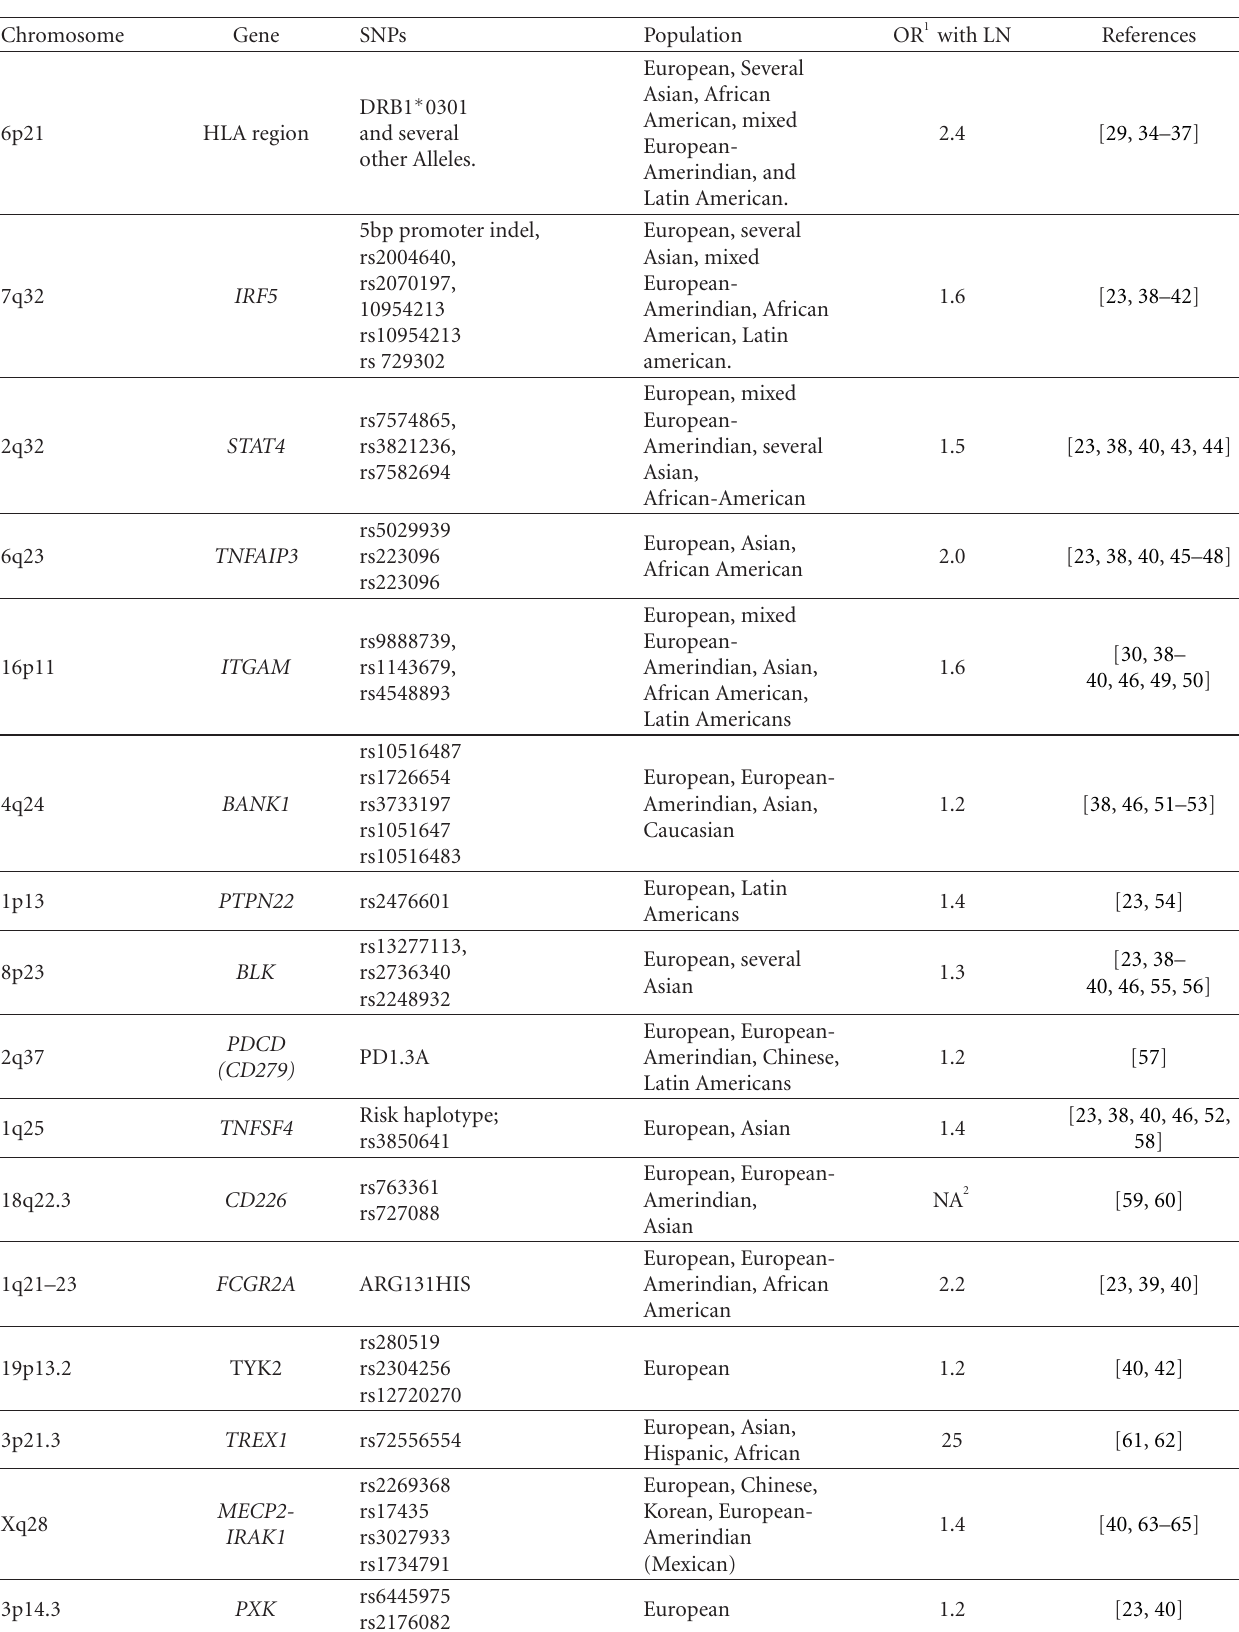
Table 1: Adapted from [32] and [33]. Susceptibility genes in SLE associated with LN.